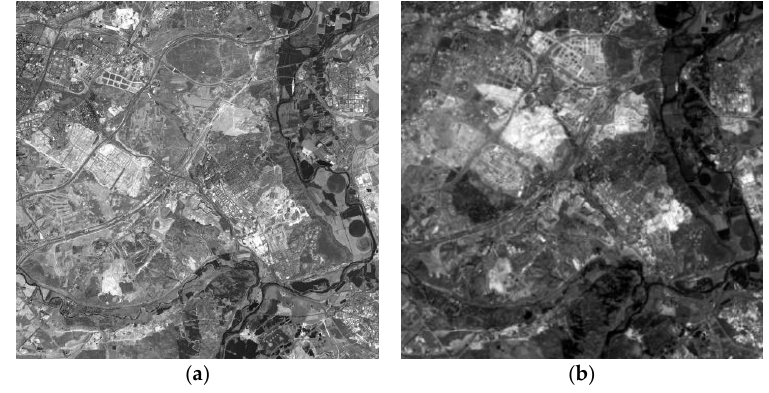
Figure 2. SPOT5-PAN (© SPOT image) multitemporal DS1: ( a ) Acquisition date 24 July 2005; ( b ) Acquisition date 17 July 2008.